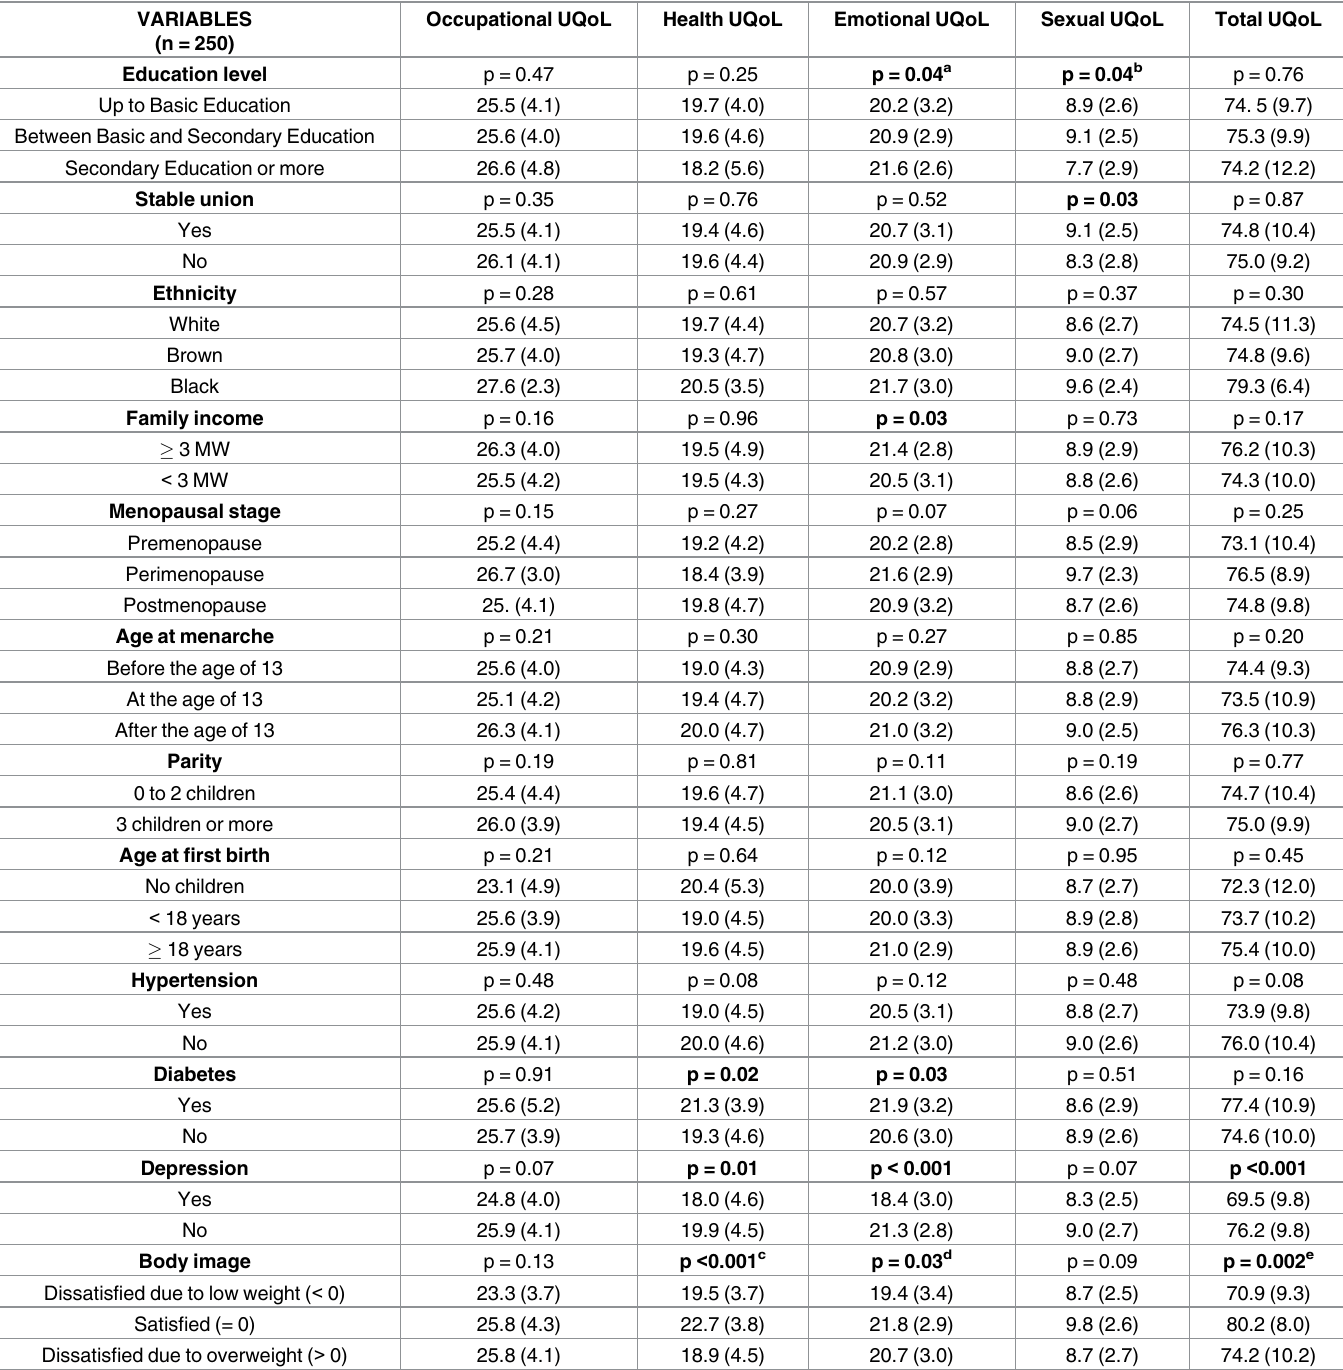
Table 2. Relationship between independent variables and the quality of life